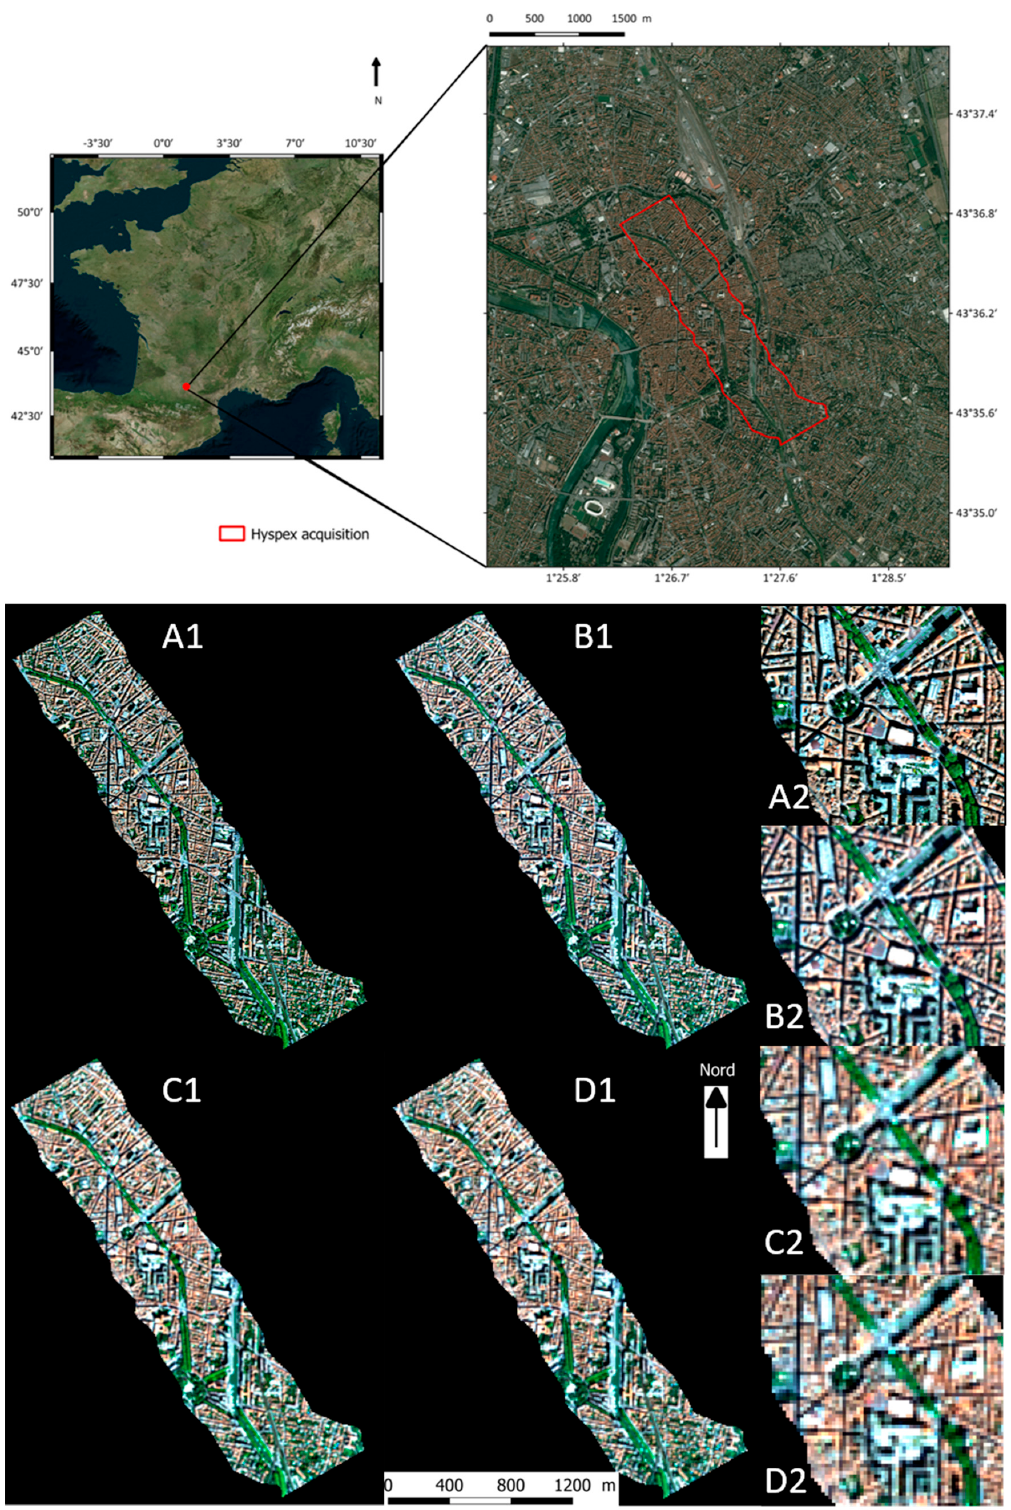
Figure 1. True color composite of hyperspectral and Sentinel2 images. (A.1) HySpex image at 2 m; (B.1) HYPXIM at 4 m; (C.1) HYPXIM at 8 m; (D.1) Sentinel2 at 10m. (A.2); (B.2); (C.2); (D.2): Zoom in the city center—RGB ( µ m): 0.665 / 0.560 / 0.490.